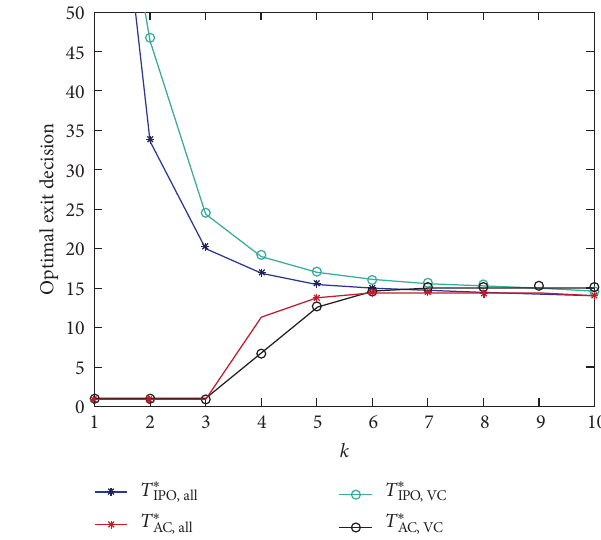
Figure 3: The payoff in IPO.